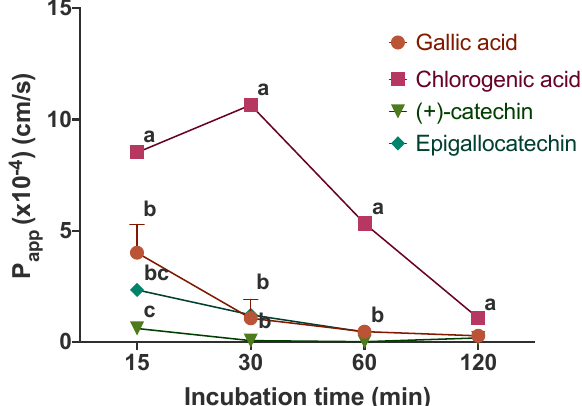
Figure 1. The apparent permeability coefficients (P app ) for the selected identified phenolics from Andean blackberry ( Rubus glaucus Benth) encapsulated in OSA-modified Gros Michel banana starch. The results are the means ± SD of two independent experiments in triplicate. Different letters express significant differences for each incubation time by the Tukey–Kramer test ( p < 0.05). P app —apparent